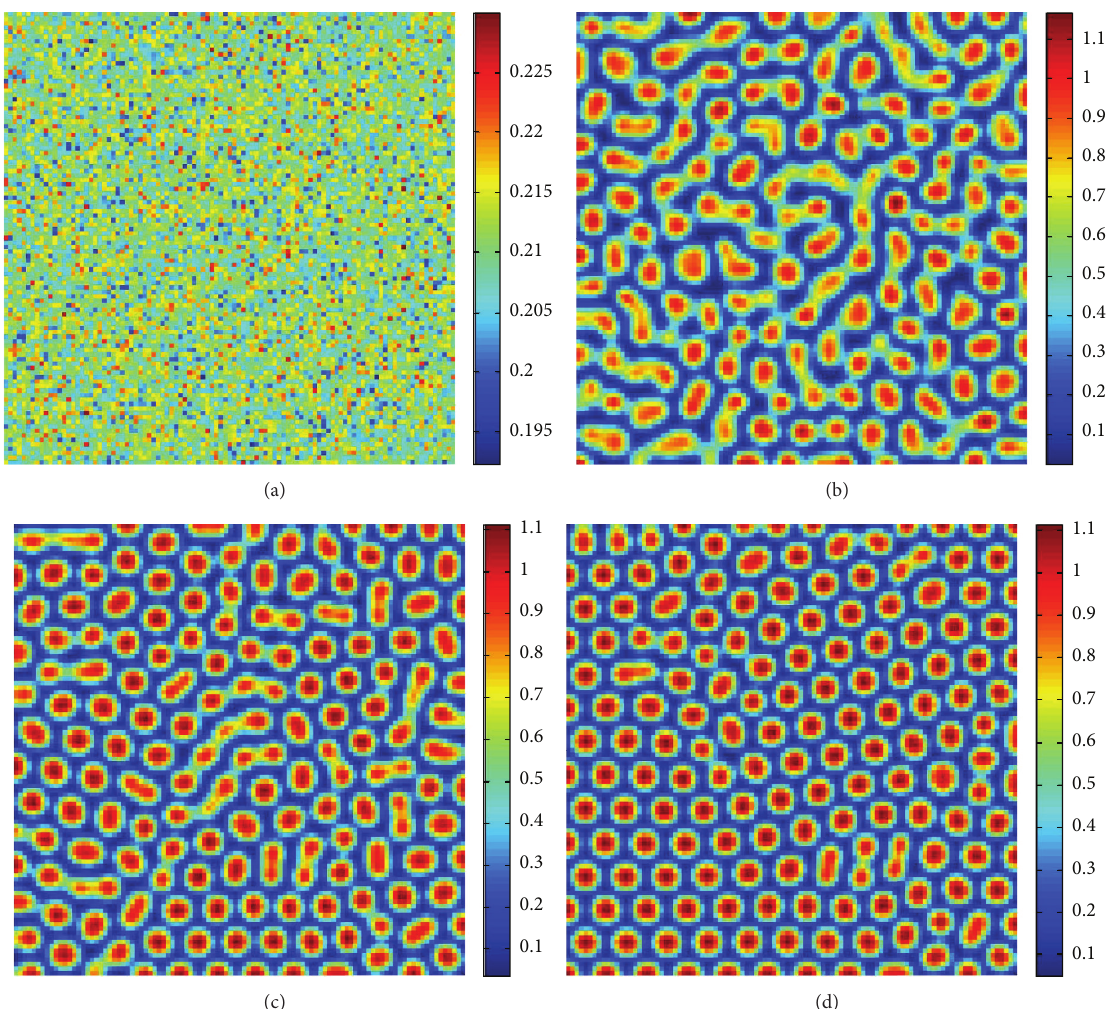
Figure 5: Spots pattern formation for model (4) by taking 𝑠 = 2.5 . Other parameters are fixed as (33). Times: (a) 0; (b) 50; (c) 250; (d) 2500.